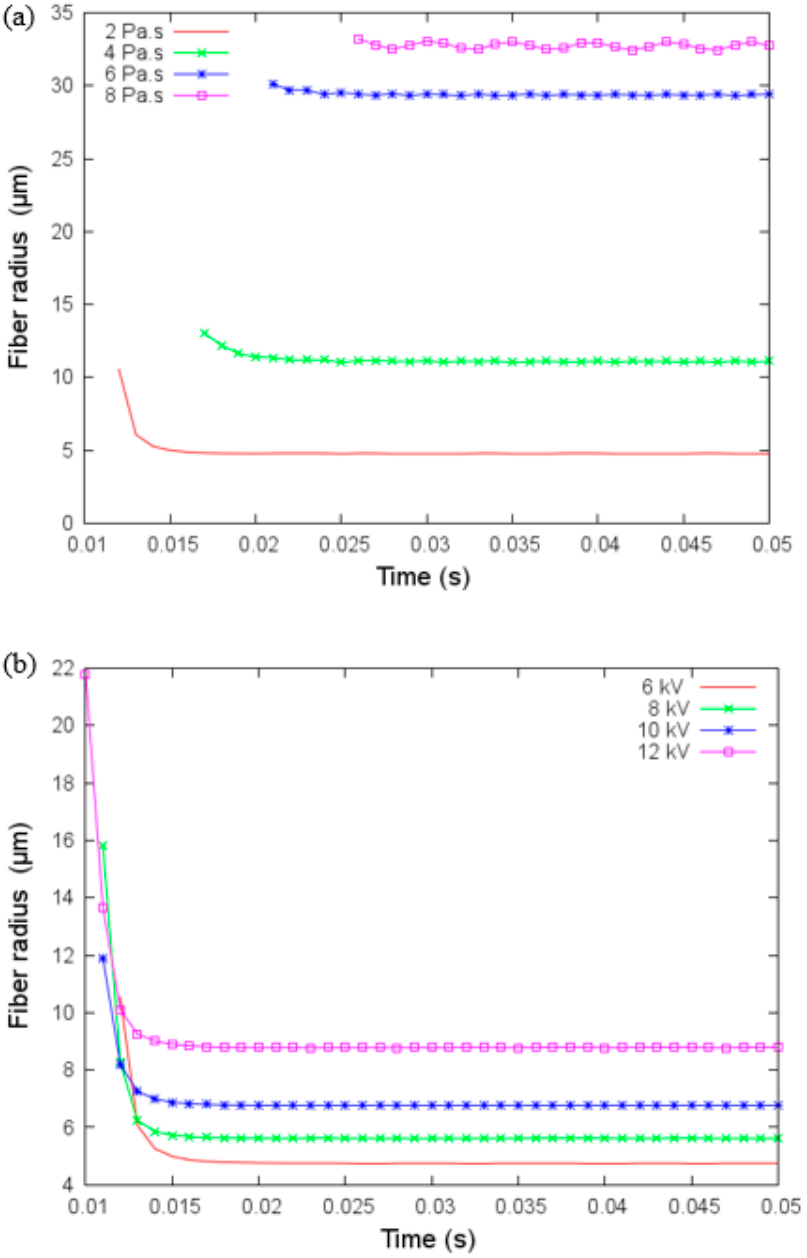
Figure 6. ( a ) Fiber radius versus time for different values of viscosity and ( b ) fiber radius versus time for different values of applied voltage under parameters given in Table 3.